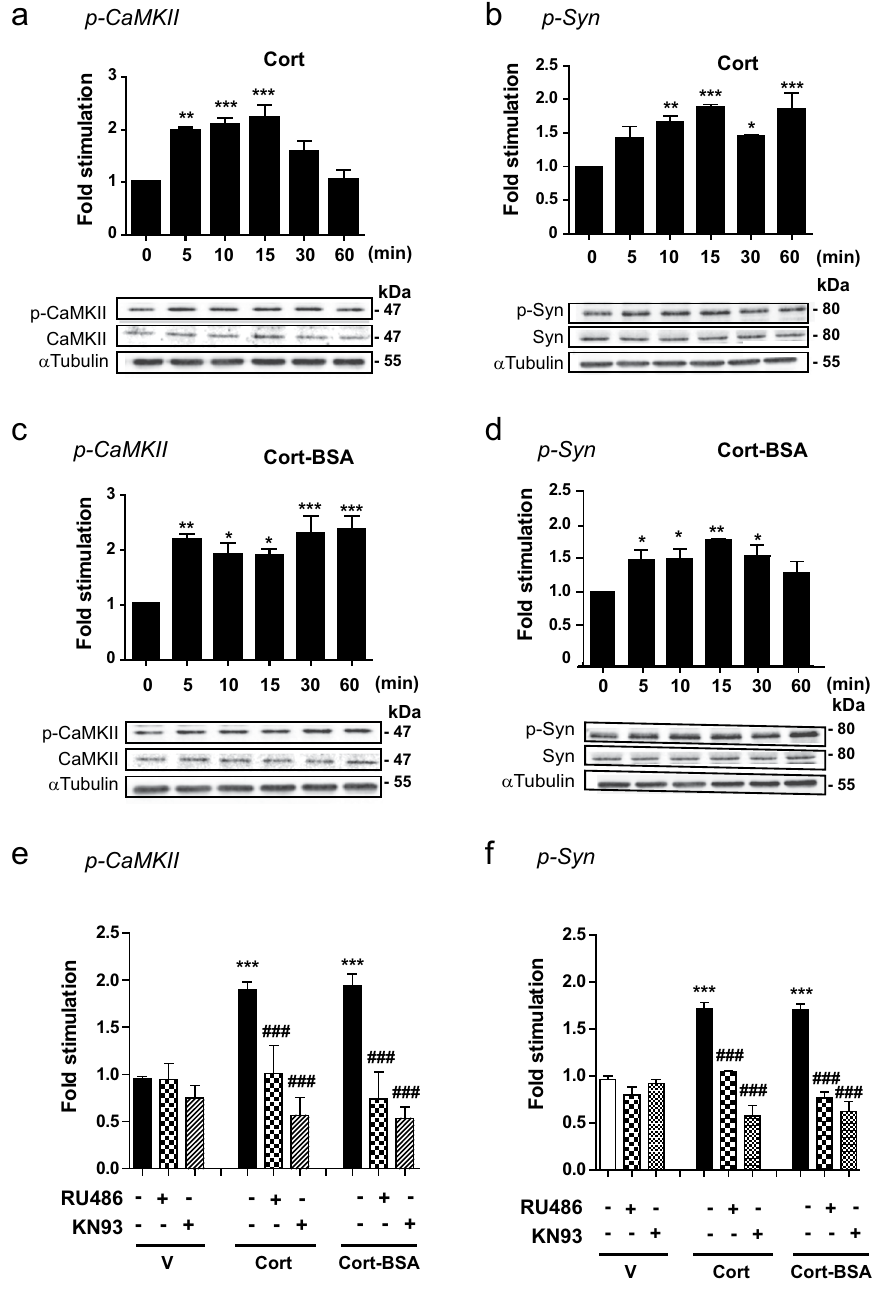
Figure 1. GC rapidly stimulate CaMKII and synapsin-I phosphorylation in L β T2 cells. ( a , b ) L β T2 cells were treated with Cort (10 − 7 M) for 0 to 60 min. Cell lysates were subjected to western blotting (WB) with anti-CaMKII ( a ), anti-p-CaMKII ( a ), anti-synapsin ( b ), anti-p-synapsin ( b ) and anti- α -tubulin antibodies ( a , b ). Cropped blots are shown in the figure and are representative of 4 independent experiments. Results are expressed as means ± SEM fold stimulation when compared to time 0. One-way ANOVA with Dunnett’s posttest, * p < 0.05, ** p < 0.01, and *** p < 0.001. ( c , d ) L β T2 were treated for 0 to 60 min with Cort-BSA (10 − 7 M). Cropped immunoblots are shown in the figure and are representative of 4 independent experiments. Results are expressed as means ± SEM fold stimulation when compared to time 0, one-way ANOVA with Dunnett’s posttest, * p < 0.05, ** p < 0.01. ( e , f ) Phosphorylated CaMKII ( e ) and Syn ( f ) were significantly increased after 5 min treatment with either Cort or Cort-BSA. These events were abolished by co-incubation with RU486 (10 − 5 M) or KN93 (10 − 5 M). V: Vehicle. Statistical significance was assessed by one-way ANOVA with Newman-Keuls Multiple Comparison Test, n ≥ 3, *** p < 0.001 when compared to Vehicle, ### p < 0.001 within the same steroid treatment (Cort or Cort-BSA). Full length WBs are presented in Supplementary Fig. S4a–c. p-CaMKII: phospho-CaMKII; p-Syn: phospho-synaspin